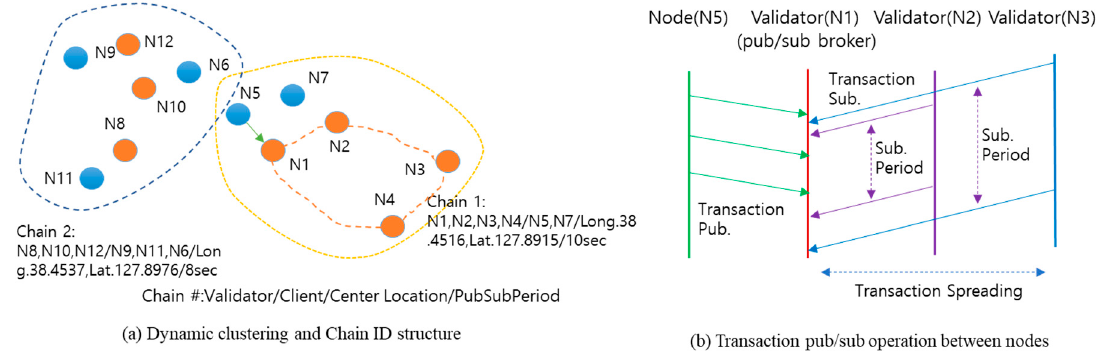
Figure 1. Dynamic blockchain network clustering: ( a ) dynamic clustering and Chain ID structure; ( b ) transaction pub/sub operation between nodes.